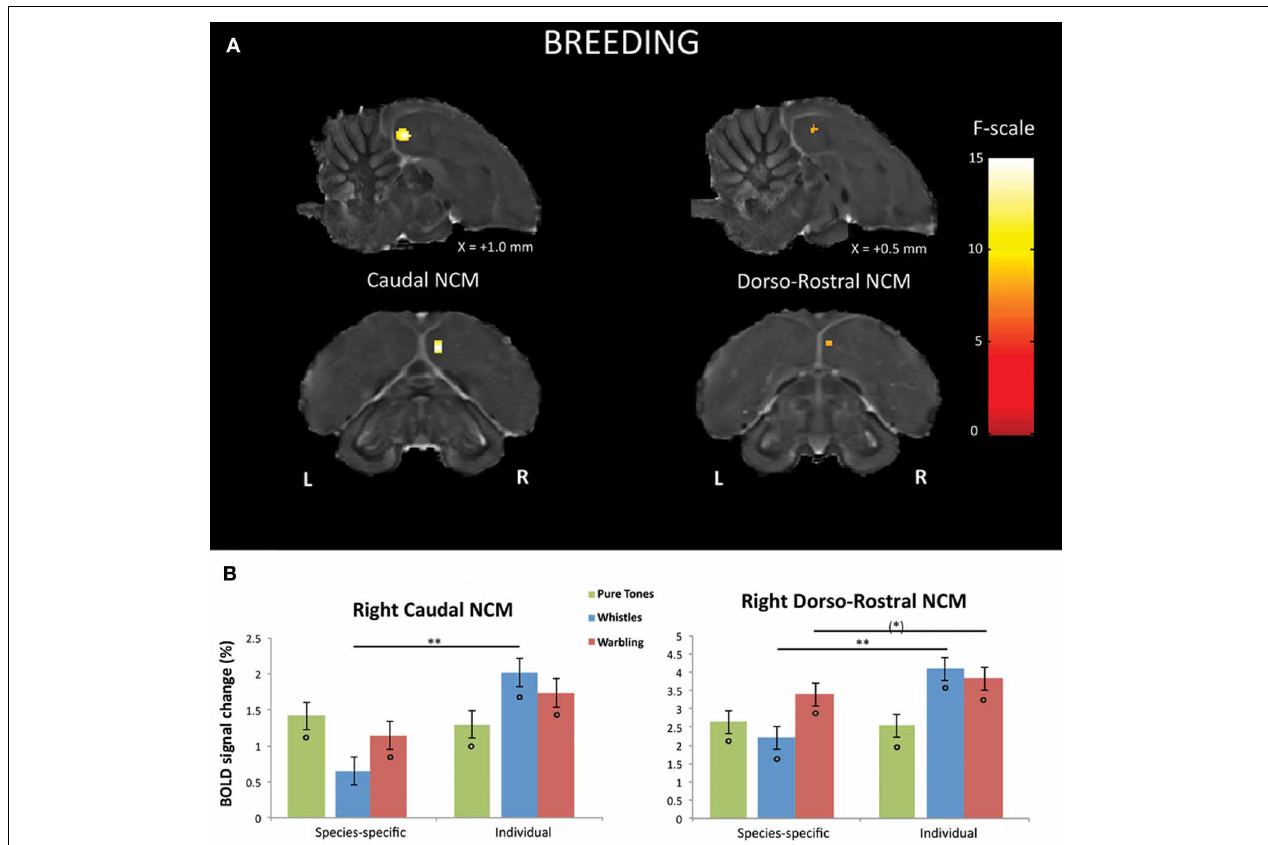
FIGURE 3 | Neural substrates for differential song processing during the breeding season. (A) Superimposition of the statistical results to anatomical sagittal and axial images coming from the high-resolution starling image. The position of the slice along the X (left/right) axis is indicated (the + sign indicates that results are from the right hemisphere). Results are of those voxels displaying a significant differential response between songs conveying species-specific and group information (SPEC) and songs conveying individual information (INDIV). F -values are color coded according to the scale displayed